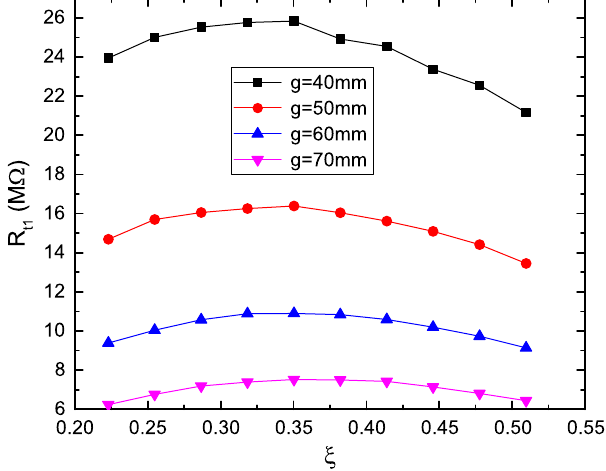
FIG. 4. Optimization of the shunt impedance of the funda- mental mode for different gaps g when b is 157